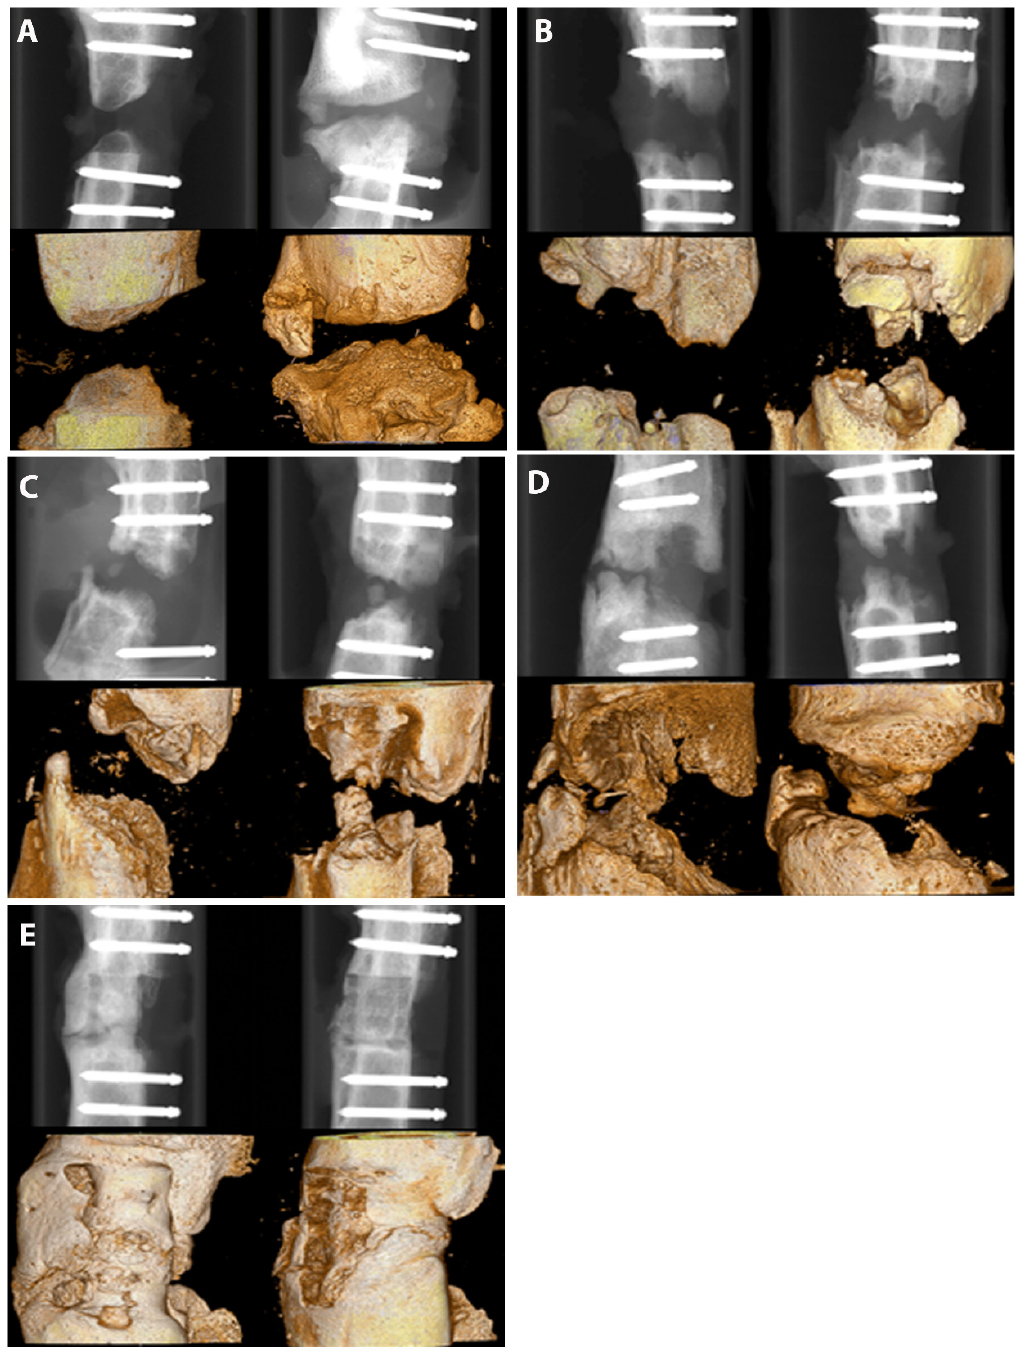
Figure 3. X-ray images of the di ff erent groups 8 weeks after surgery. Group 1—no implant—( A ); 2—PLA cylinder alone—( B ); 3—PLA cylinder + collagen type I—( C ); 4—PLA cylinder + collagen type I + SDF-1—( D ); 5—PLA cylinder + collagen type I + BMP-7—( E .